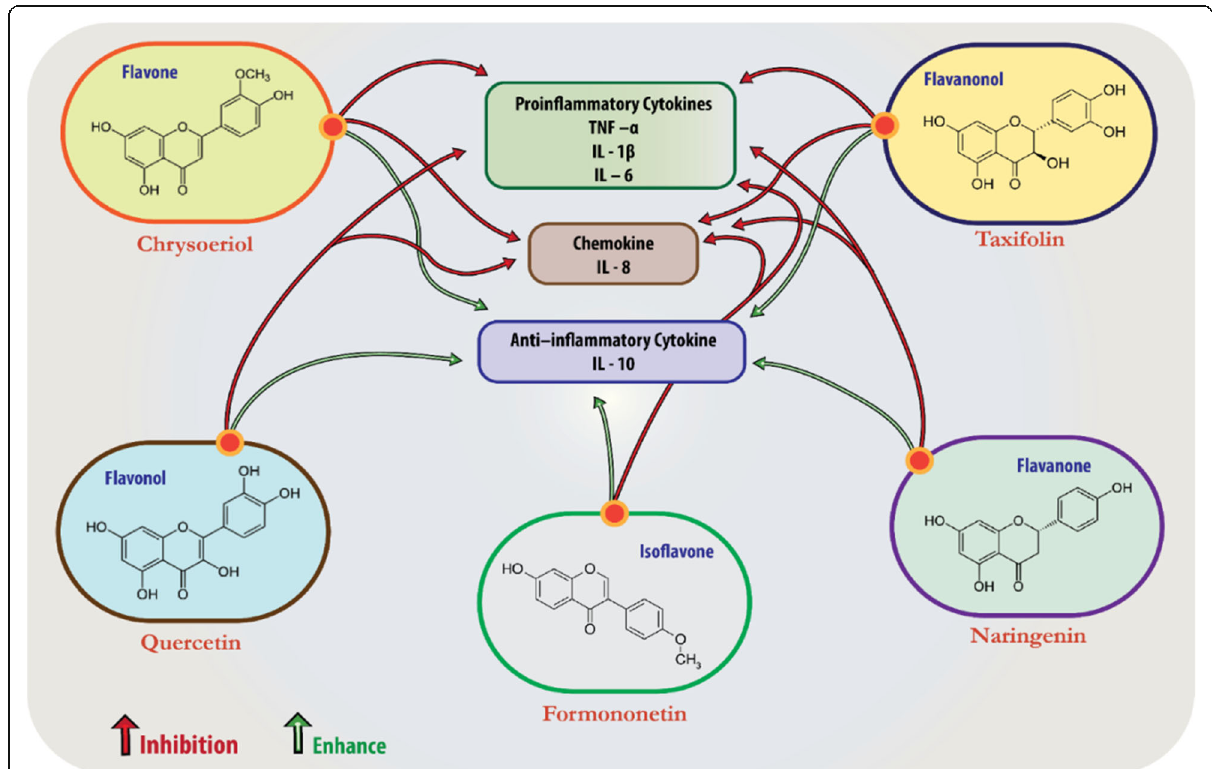
Fig. 5 Possible anti-inflammatory inhibition mechanism of flavonoids from P.